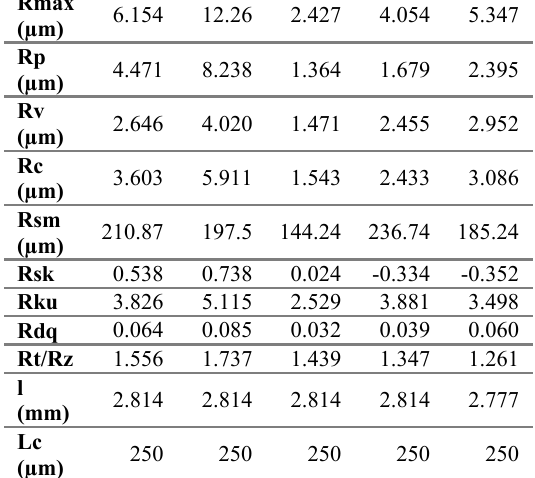
Table 1. Experimental data of Test rig